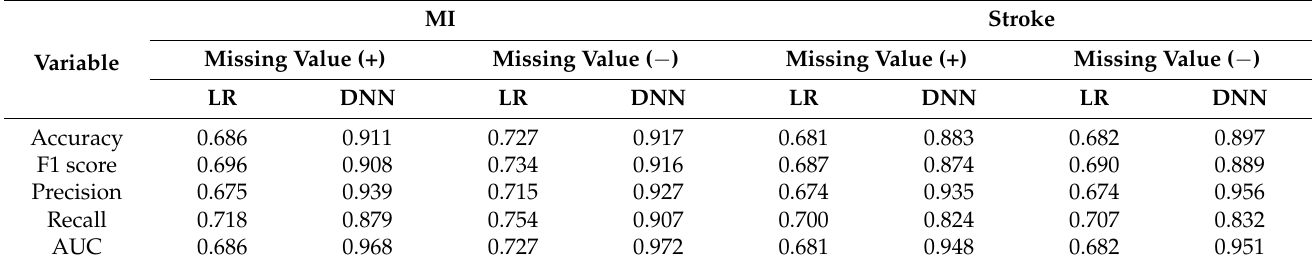
Table 4. Performances of logistic regression and deep neural network models for MI and stroke.